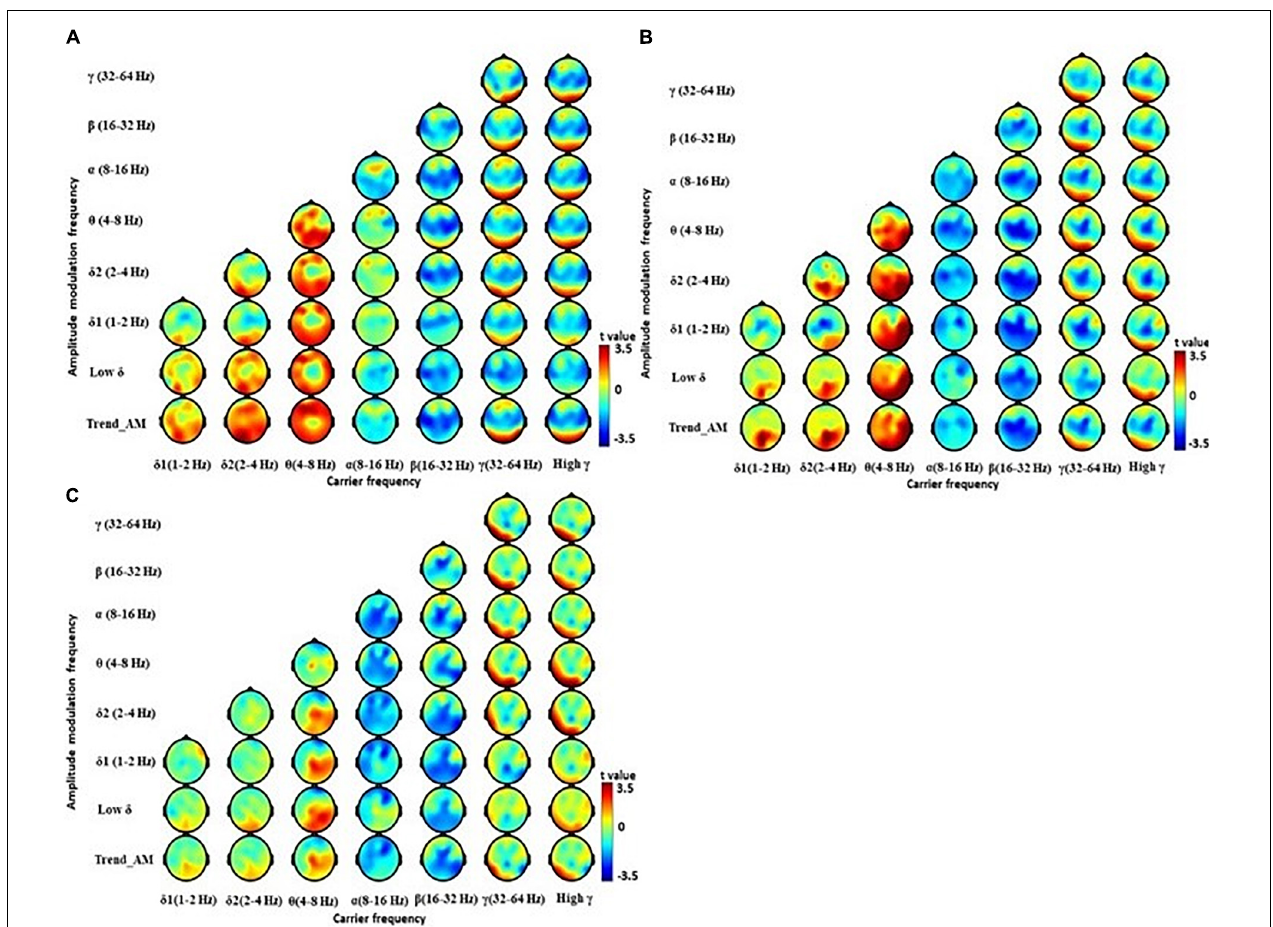
FIGURE 3 | Electroencephalography power difference between PD at early (EPD) and late stage (LPD) using Holo-Hilbert Spectrum Analysis (HHSA). Holo-Hilbert topography (HHT) in the eyes-closed minus the eyes-open condition based on cluster-based non-parametric permutations in the (A) EPD minus healthy control (HC), (B) LPD minus HC, and (C) LPD minus EPD. The color bar denotes t -values ranging from blue (–3.5) to red